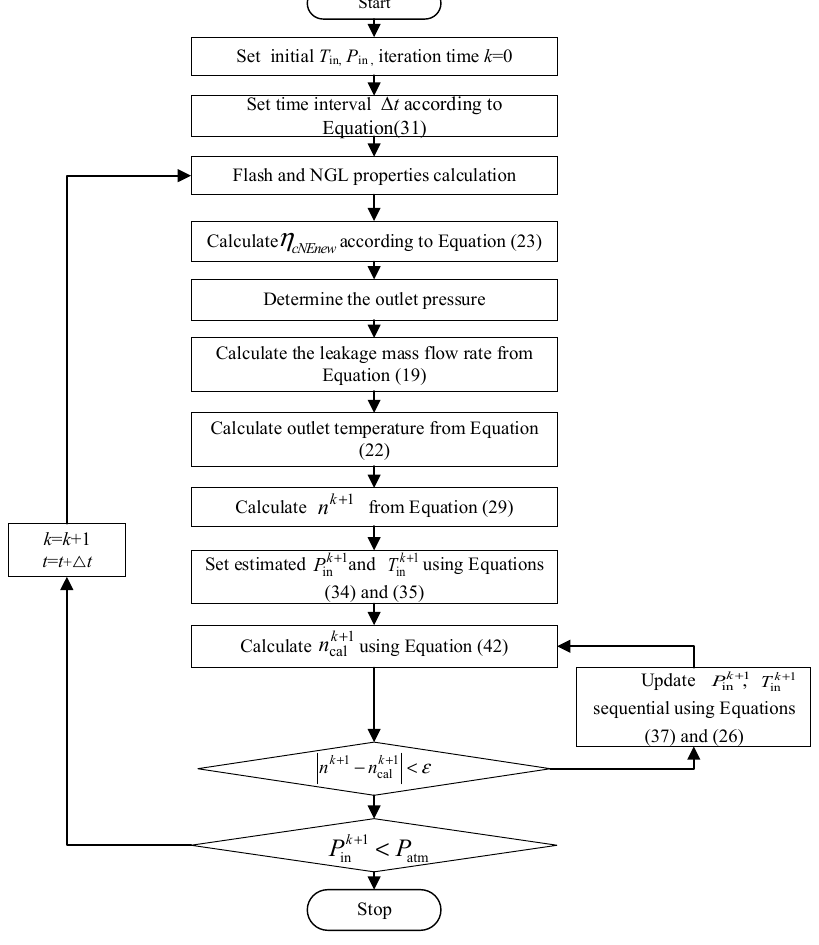
Figure 4. Flow chart of the solution procedure.